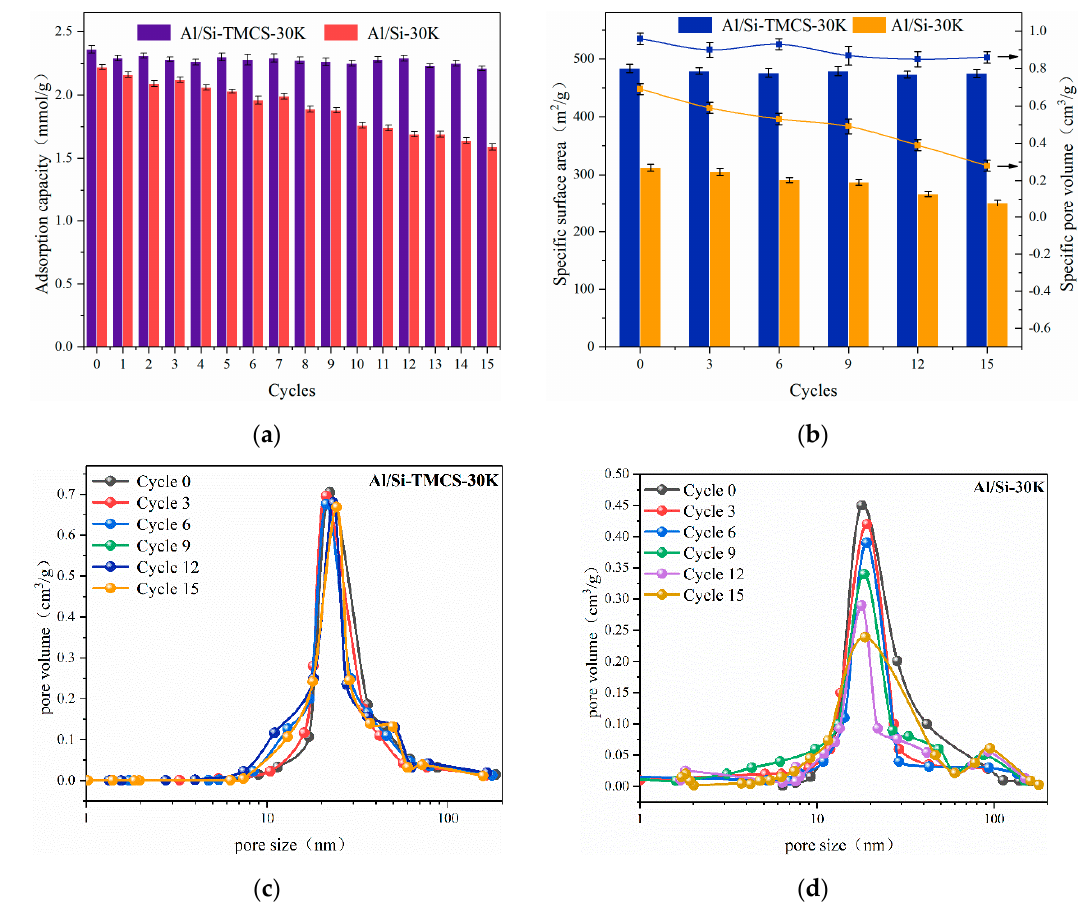
Figure 11. Cycling performance of Al-TMCS-30K and Al-TEOS-30K. ( a ) Adsorption capacity during the cycle. ( b ) Microstructural parameters during the cycle. ( c ) Pore size distribution during the cycle. ( d ) Pore size distribution during the cycle.